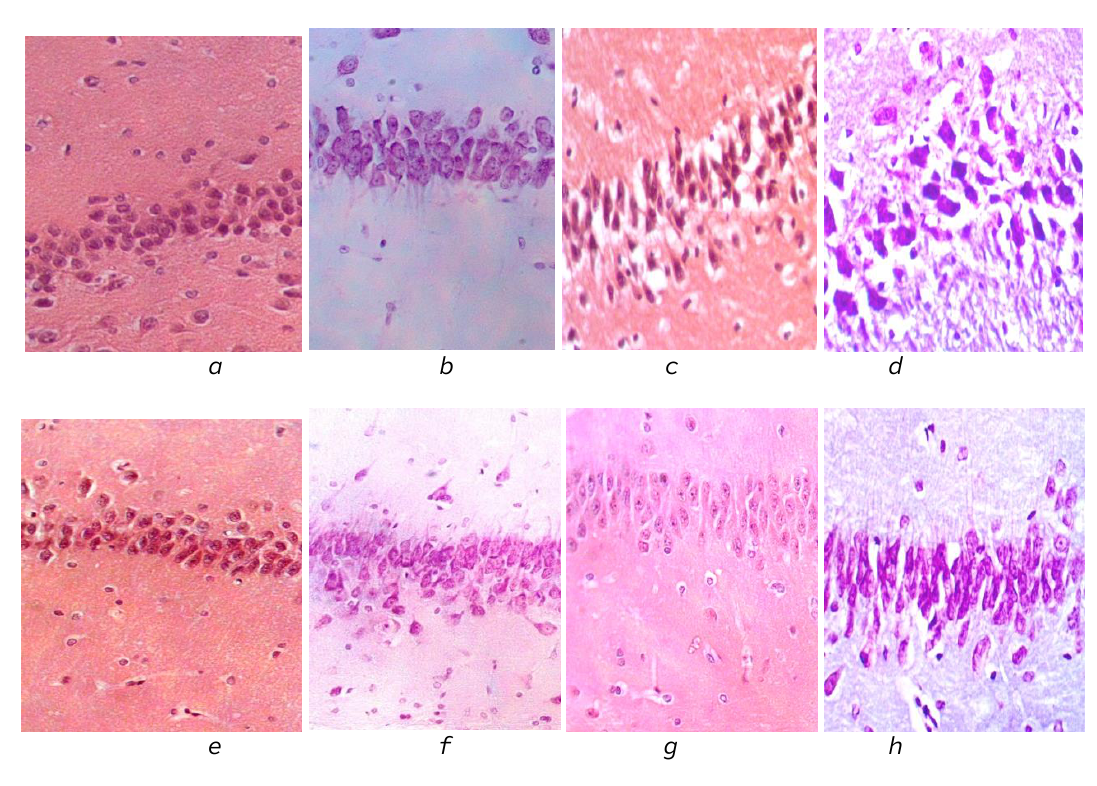
The area of the perikaryon of neurons of the pyramidal layer CA with the ACVA model under the influence of the studied drugs